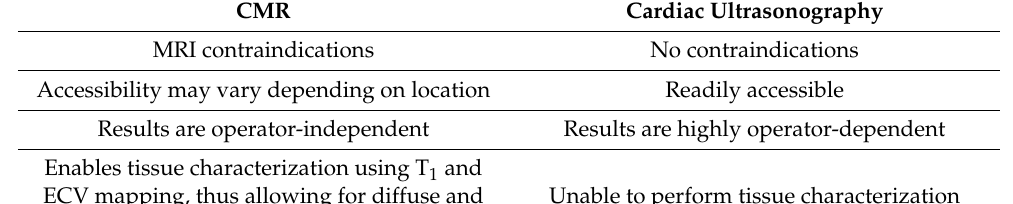
Table 1. Cont. CMR Cardiac Ultrasonography MRI contraindications No contraindications Accessibility may vary depending on location Readily accessible Results are operator-independent Results are highly operator-dependent Enables tissue characterization using T 1 and ECV mapping, thus allowing for diffuse and Unable to perform tissue characterization focal fibrosis assessment Diastolic function is assessable through 4D Diastolic function is readily assessable through flow CMR Doppler and tissue Doppler ultrasonography Myocardial perfusion is assessable through Myocardial perfusion is assessable through contrast-based perfusion CMR contrast-based ultrasonography Gold standard for the assessment of ventricular volumes and function (cine MRI) and No gold standard myocardial strain (tagging)